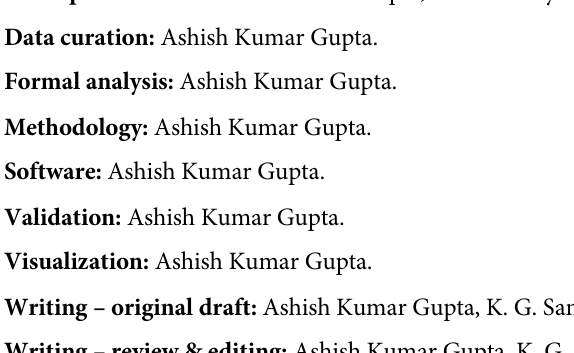
S1 Table. Difference in outcome variable and selected characteristics between districts that were included in the analysis and those that were excluded. S2 Table. Diagnostics analysis of degree of multicollinearity in explanatory